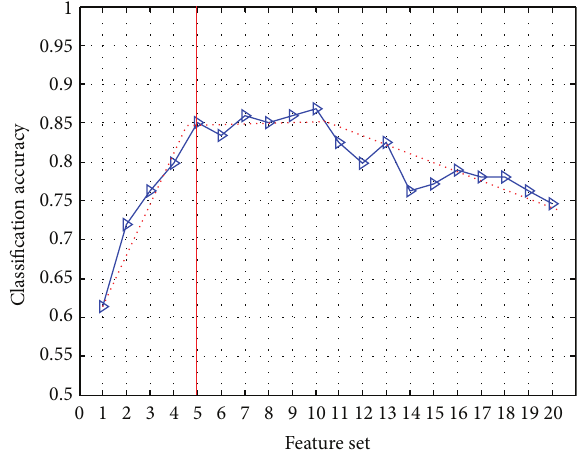
Figure 7: Classification accuracy for the feature sets.